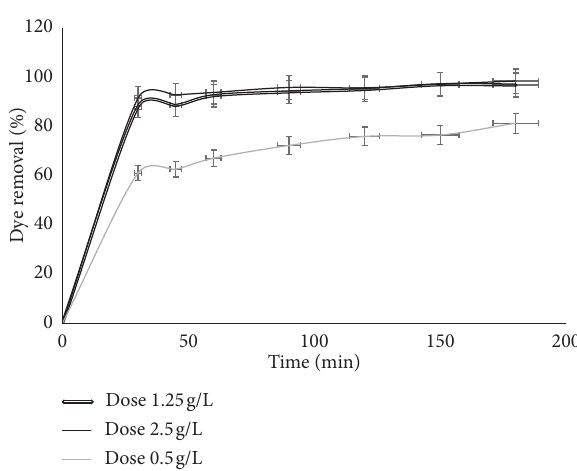
Figure 3: Percent dye removal as a function of time for GB sorbent in water at 20 ° C for different sorbent doses.